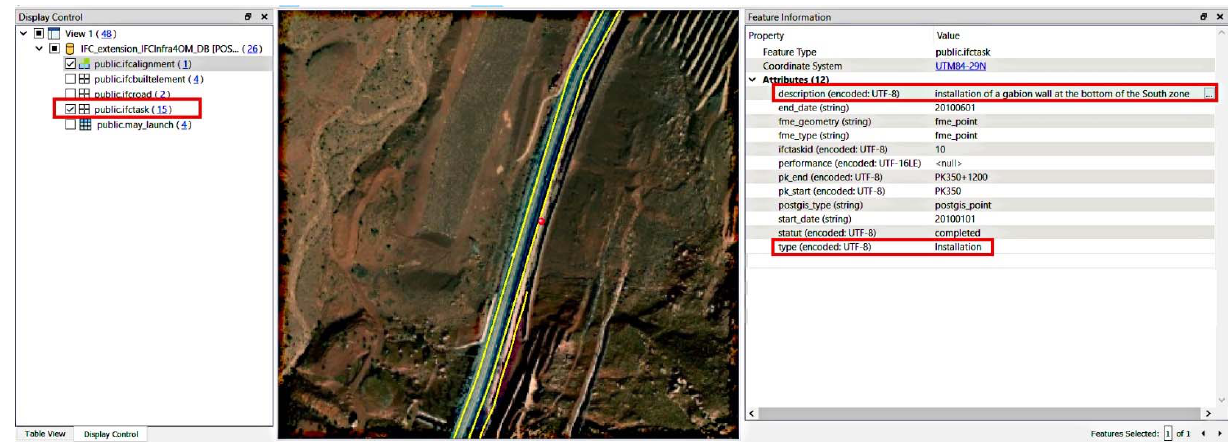
Figure 9. IFCBuiltElement “Dynamic Barrier” three-dimensional view from the Highway Information Model.